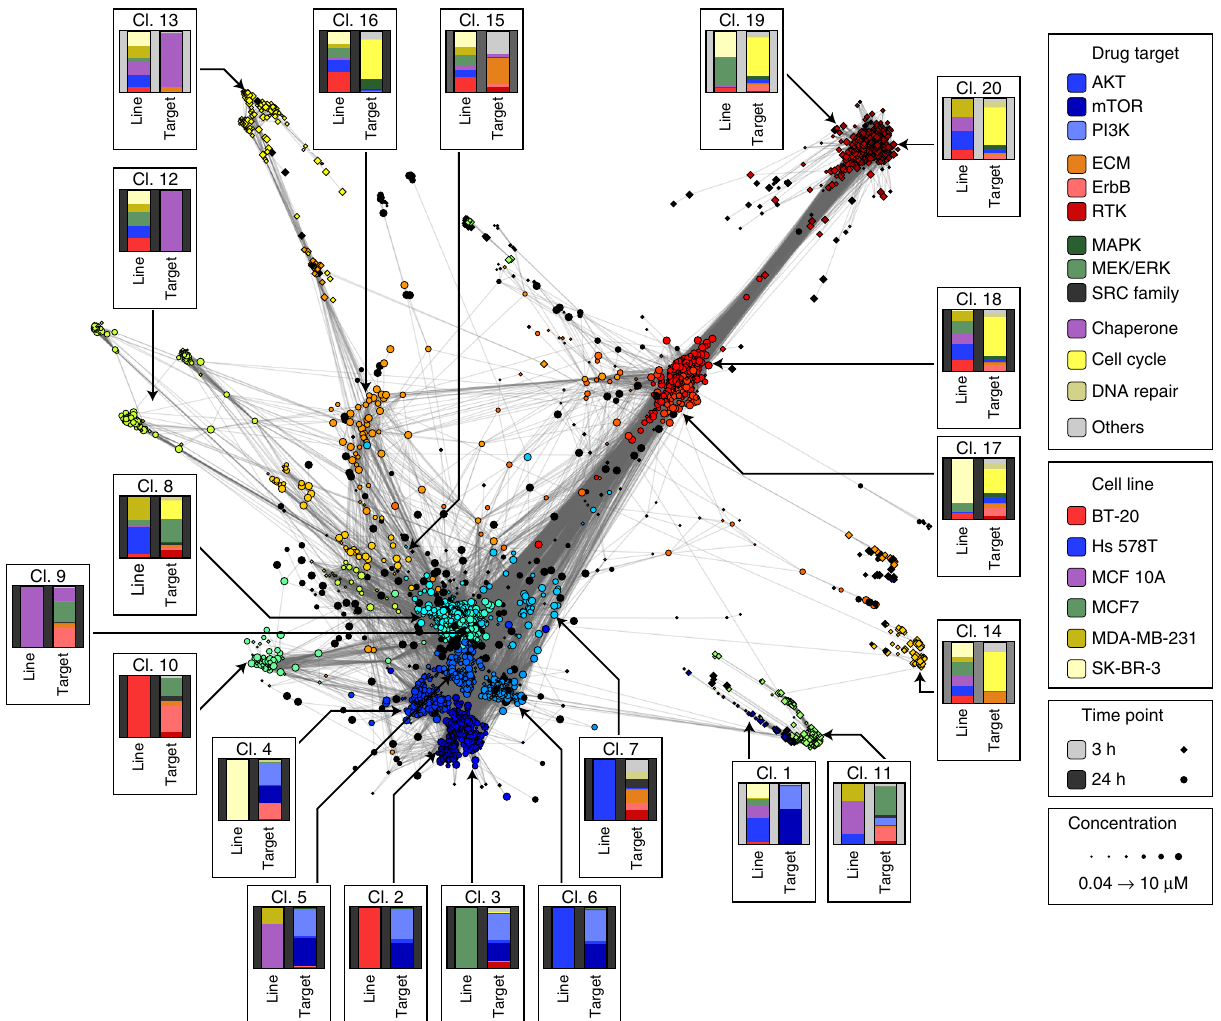
Fig. 1 Drug responses based on transcriptional signatures can be cell type speci fi c or universal. A network of consistent L1000 signatures (SCS > 1.3) scored using the characteristic direction approach. Each node represents a unique perturbation (a combination of drug, cell line, time point and concentration) and edges are drawn between perturbations having a cosine distance in the lower 2-percentile. Color is based on cluster identity, size denotes concentration, and shape denotes the time point. For each cluster, a box labeled with the cluster number illustrates the distribution of the perturbation by cell line (left bar) and drug target class (right bar). Target classes are assigned based on the nominal targets of a drug and do not consider potential poly-pharmacology. The drugs assigned to each class are listed in Supplementary Data 1. An interactive version of this fi gure is available at